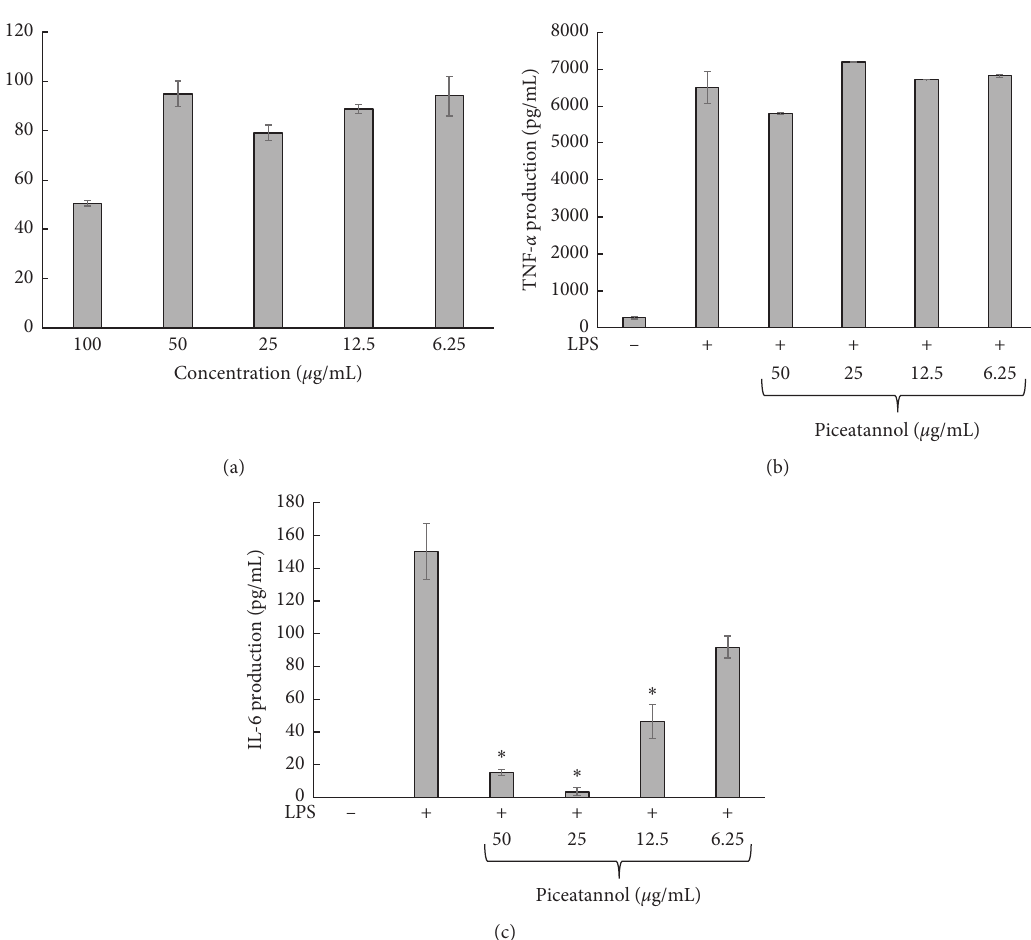
Figure 6: Effect of piceatannol on RAW264.7 cell viability (a), TNF- α production (b), and IL-6 production (c); ∗ p < 0 . 05 when compared with LPS-stimulated condition.